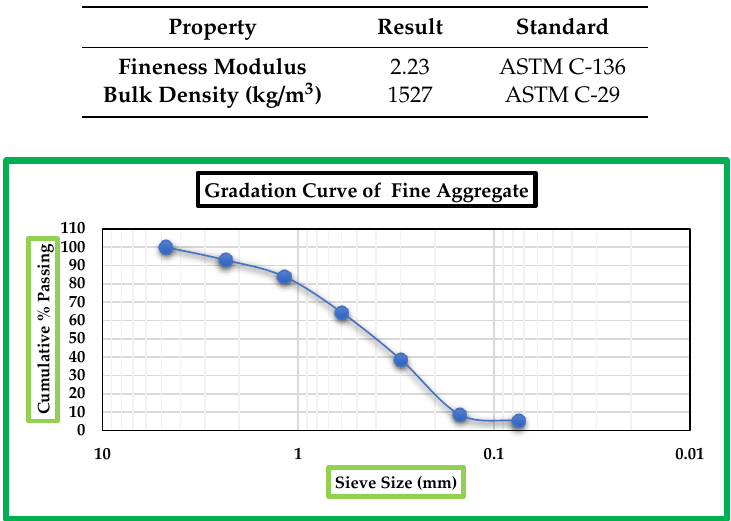
Figure 1. Grain size distribution (sieve) analysis of fine aggregate.